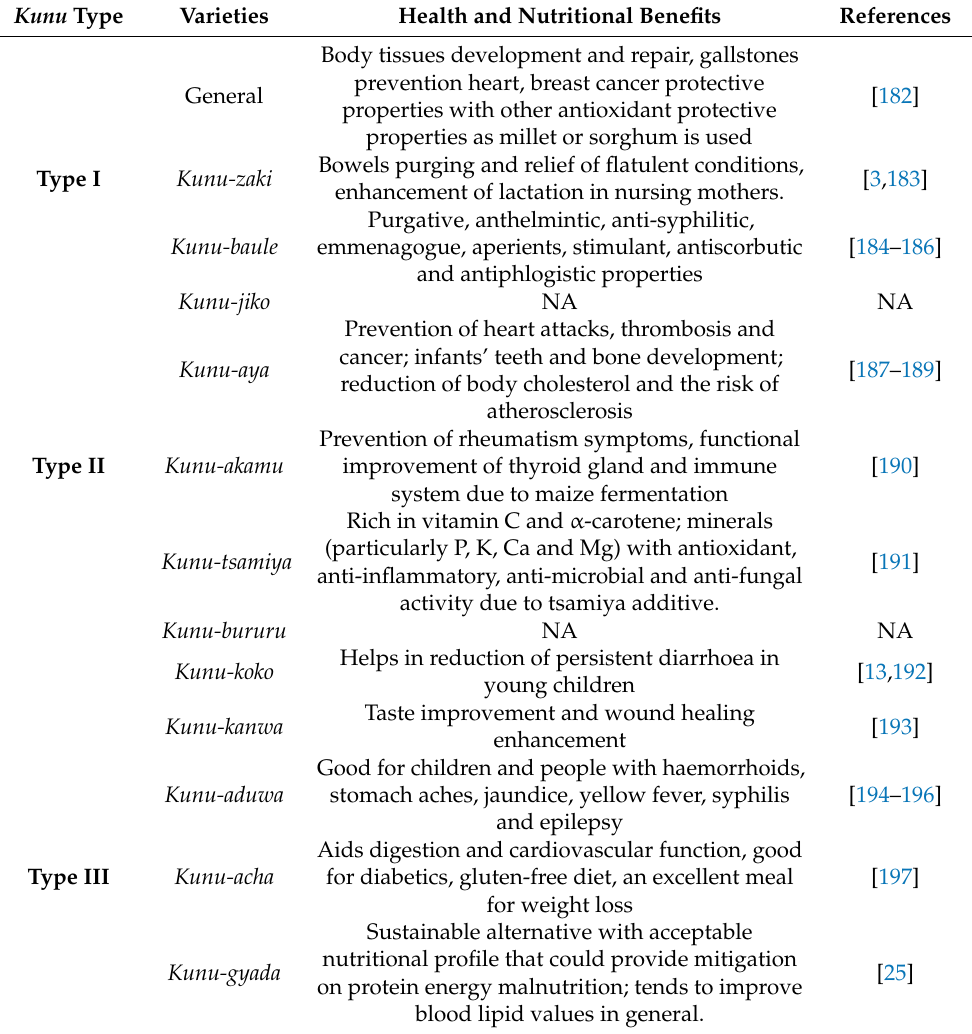
Figure 3. Prospects of Kunu drinks for human health benefit. Table 4. Health and nutritional benefits associated with different varieties of Kunu beverages.